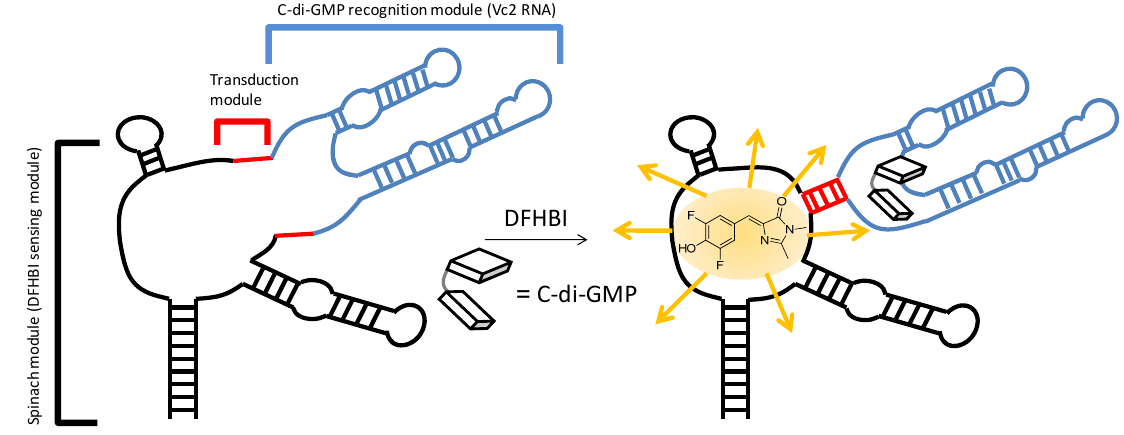
Figure 5. c-di-GMP fluorescent riboswitch. Sequence of RNA is, 5'-GAC GCG ACU GAA UGA AAU GGU GAA GGA CGG GUC CAG GC C GCA CAG GGC AAA CCA UUC GAA AGA GUG GGA CGC AAA GCC UCC GGC CUA AAC UUC GGU AGG UAG CGG GGU UAC CGA GC CUU GUU GAG UAG AGU GUG AGC UCC GUA ACU AGU CGC